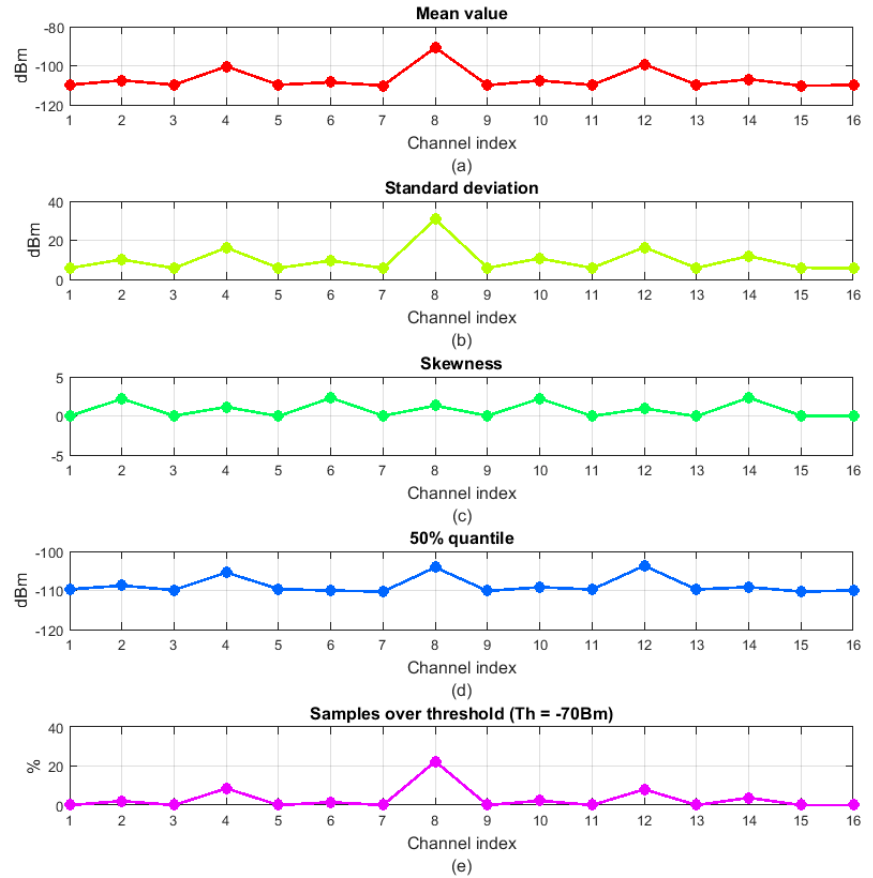
Figure 4. Different statistical properties obtained from the RSSI values in Figure 2: ( a ) Mean value; ( b ) Standard deviation; ( c ) Skewness; ( d ) 50% quantile; ( e ) SOTH with − 70 dBm threshold.